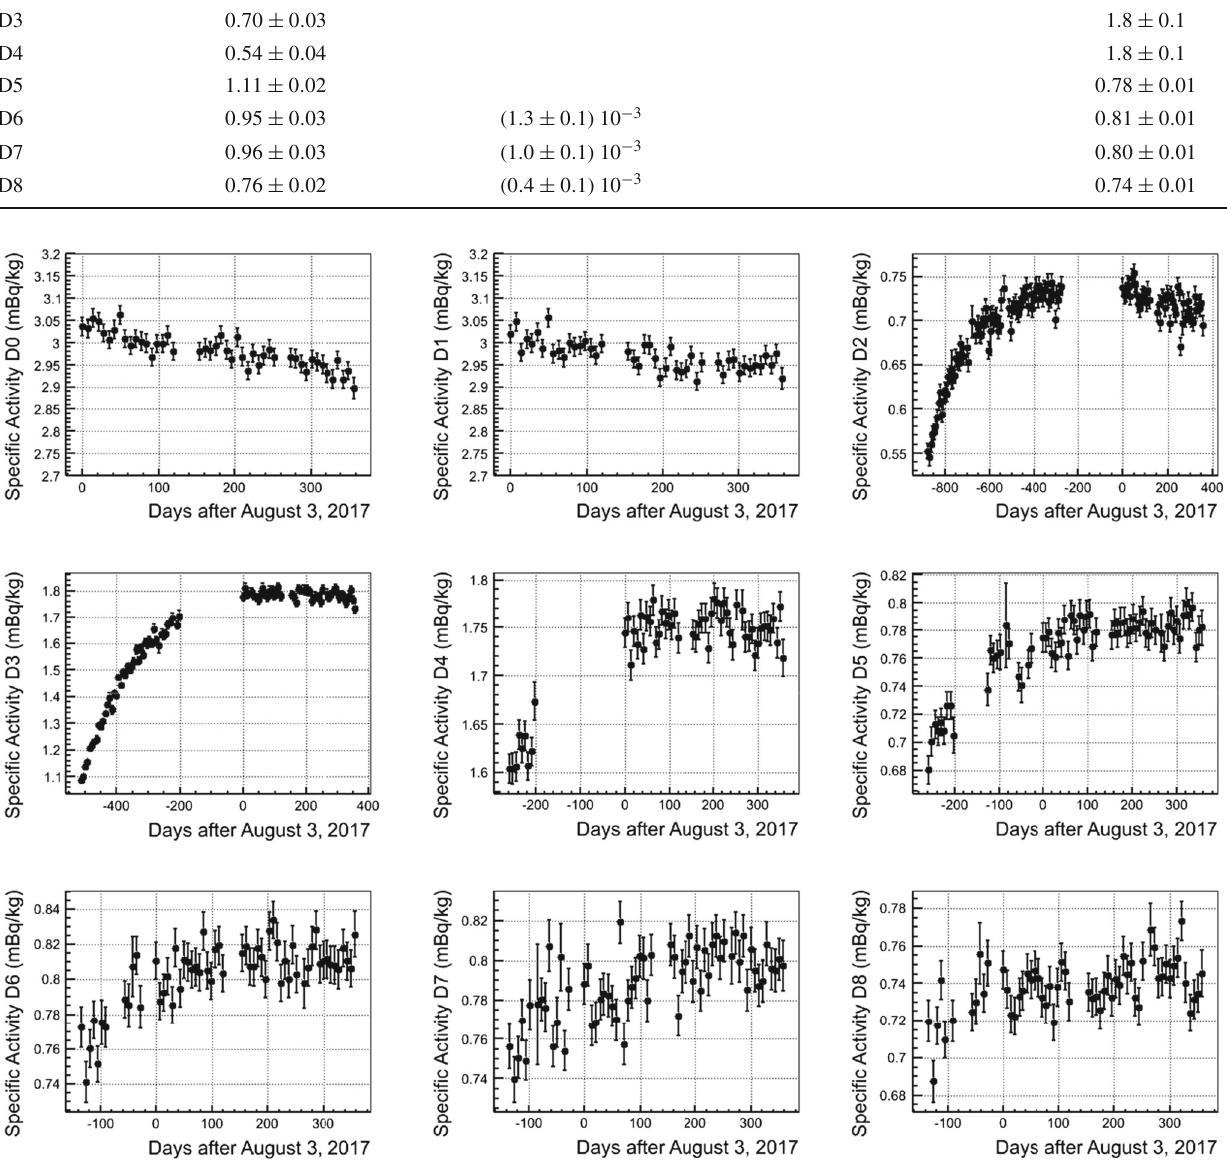
Fig. 3 Measured alpha specific activity determined through PSA as a function of time for all the detectors in the ANAIS-112 set-up during the first year of data taking. Activity since the arrival to LSC of each detector is also shown for D2–D8